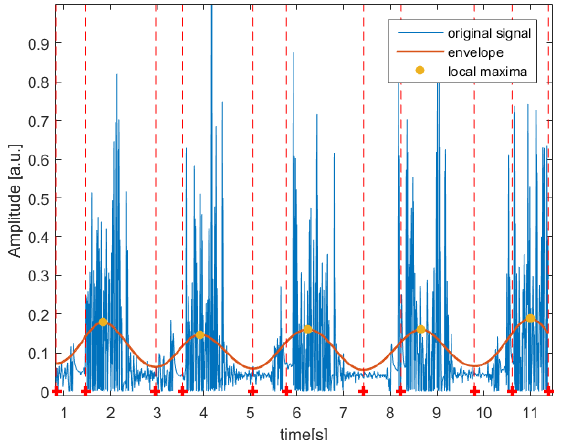
Figure 3. Segmentation result obtained for an example left temporomandibular joint (TMJ) acoustic signal recorded from a patient complaining about pain in left TMJ and diagnosed with left joint arthralgia. The red dashed line corresponds to the beginning and end of every segment.